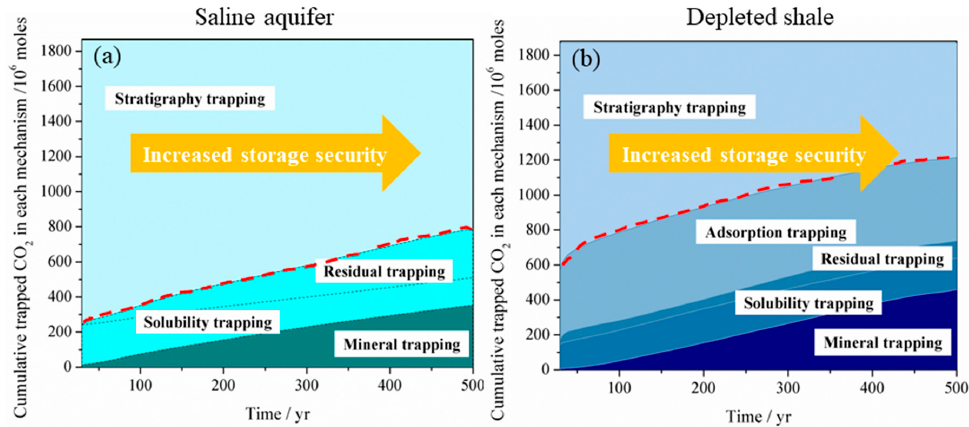
Figure 10. Storage security of CO 2 in ( a ) a deep saline aquifer and ( b ) in a depleted shale reservoir.